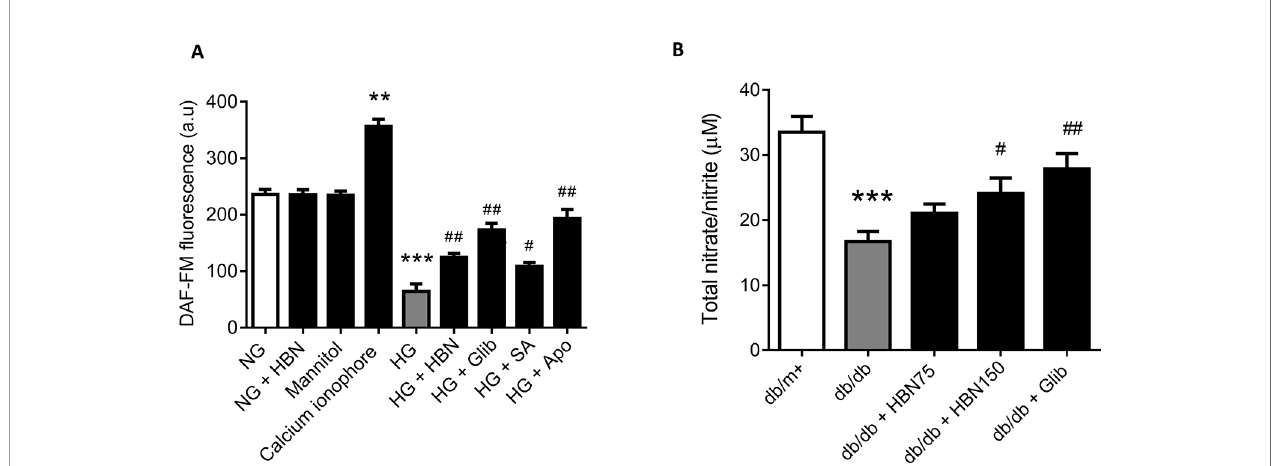
FIGURE 5 | (A) Nitric oxide (NO) level as measured by DAF-FM after treatment with normal glucose (NG, 5 mM), high glucose (HG, 30 mM), mannitol (25mM), H2O2 (200 µM), calcium ionophore (A23187, 5 µM), hydrolyzed bird nest (HBN, 30 m g/mL), sialic acid (SA, 20 m g/mL), glibenclamide (Glib, 10 m M), and apocynin (Apo, 20 m M) in HUVECs for 48 h. (B) in serum of db/db mice treated with hydrolyzed bird nest (HBN, 75 and 150 mg/kg) and glibenclamide (1 mg/kg) for four weeks. Results are mean ± SEM of three experiments. **P < 0.01 and ***P < 0.001 compared to control; # P < 0.05 and ## P < 0.01 compared to